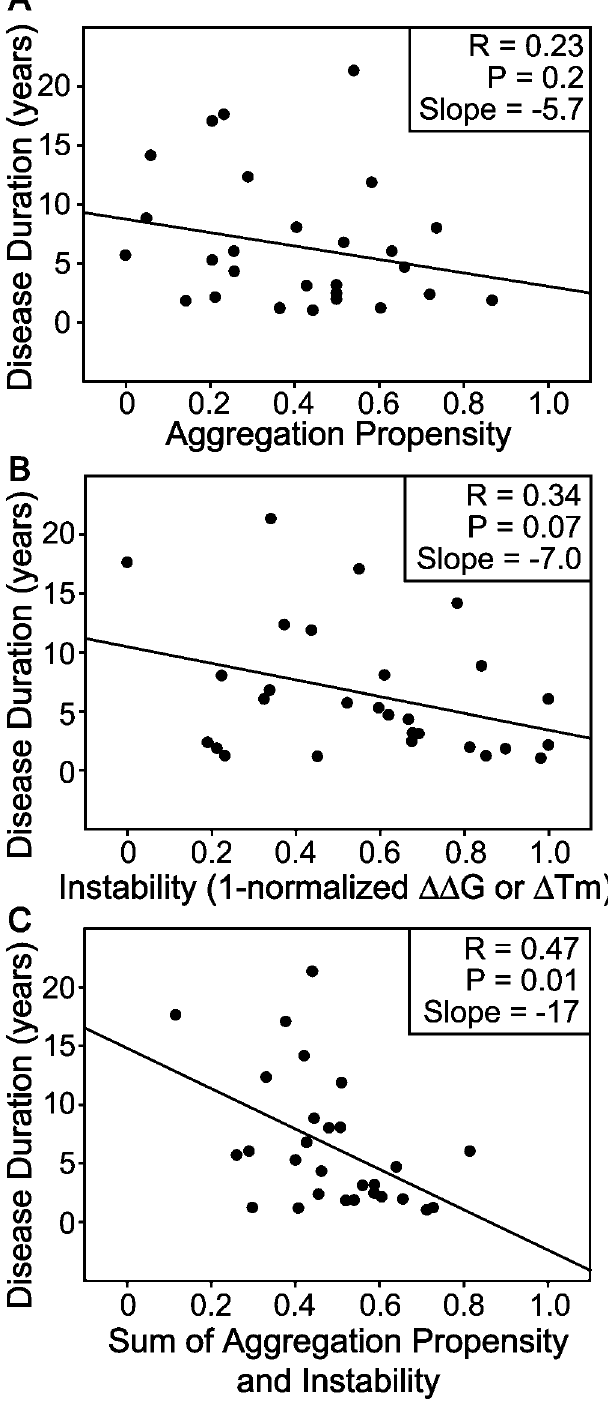
Figure 4. Synergistic Increases in SOD1 Aggregation Propensity and Losses of Thermodynamic Stability Are Associated with Decreased Survival of fALS Patients (Using Unweighted Data) (A) An increase in aggregation propensity is associated with decreased fALS patient survival. Single point mutations found in fALS patients with corresponding reported thermodynamic stabilities in (B) were consid- ered. (B) A loss of SOD1 thermodynamic stability is associated with severe disease. (C) Increase in SOD1 aggregation propensity and gain of instability synergistically decrease patient survival. The data used in these three